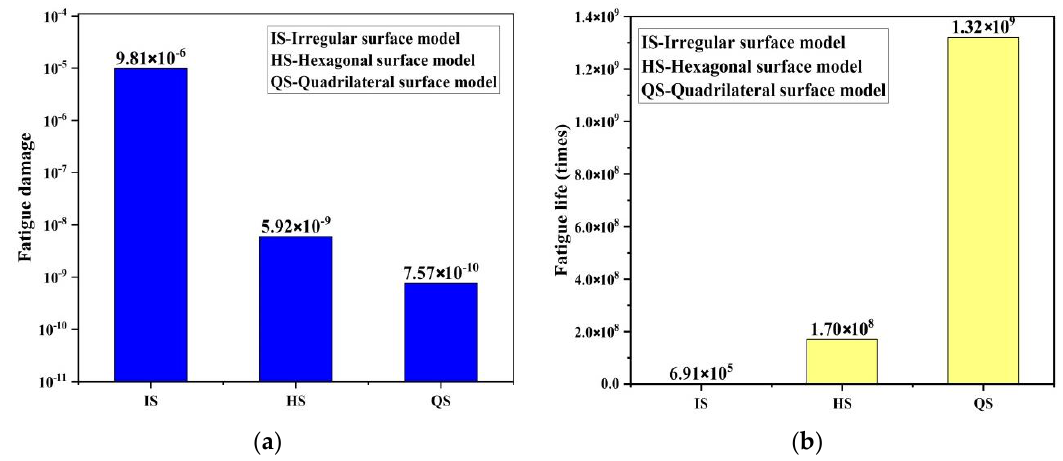
Figure 9. Comparison of fatigue features of three different form models: ( a ) fatigue damage, and ( b ) fatigue life. and ( b ) fatigue